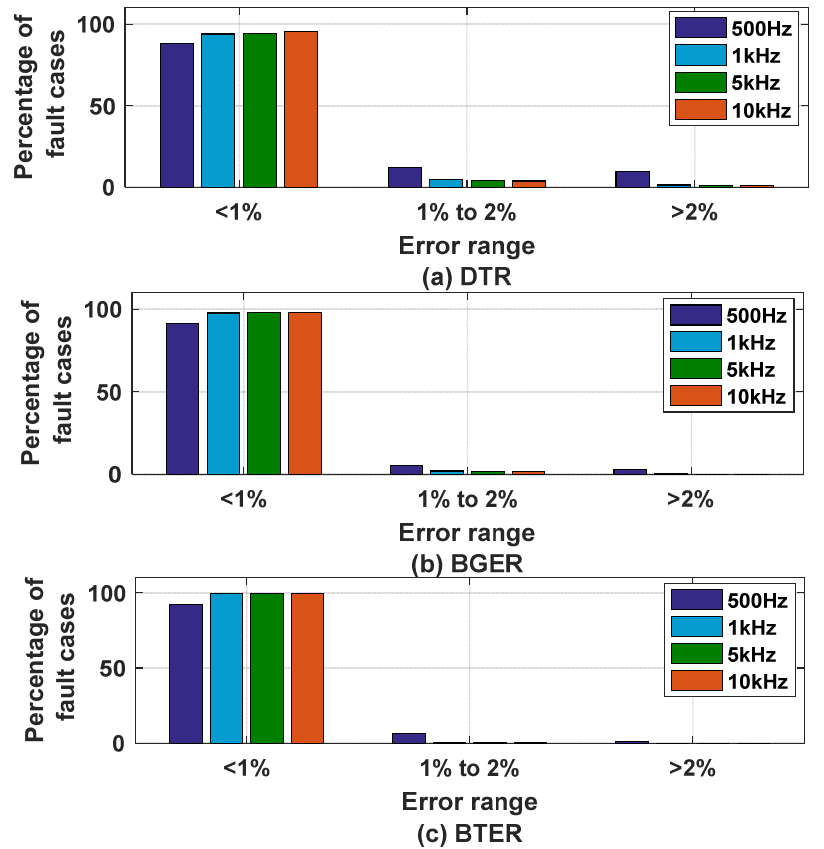
Figure 11. Performance varying sampling frequency ( a ) DTR ( b ) BGER ( c ) BTER.